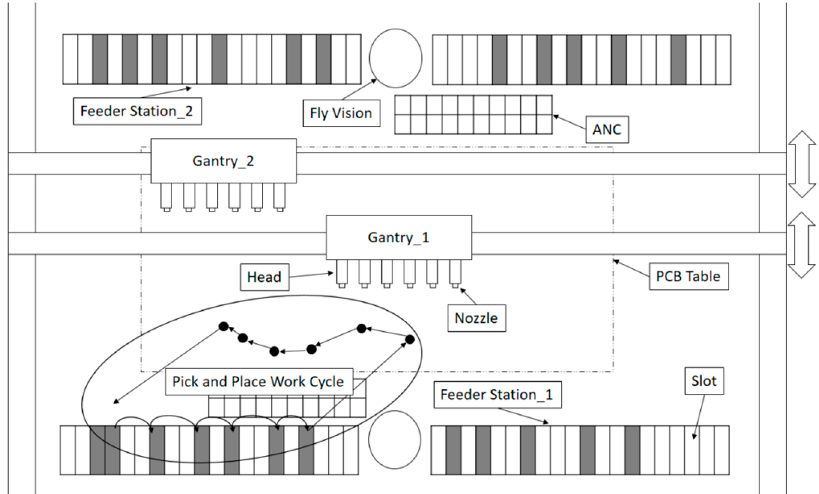
Figure 1. Dual-gantry, multi-head SMP machine.